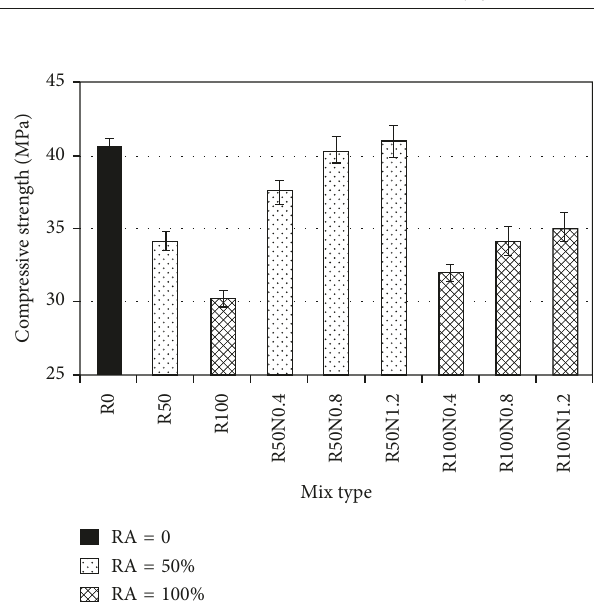
Figure 3: Compressive strength of all mixes.